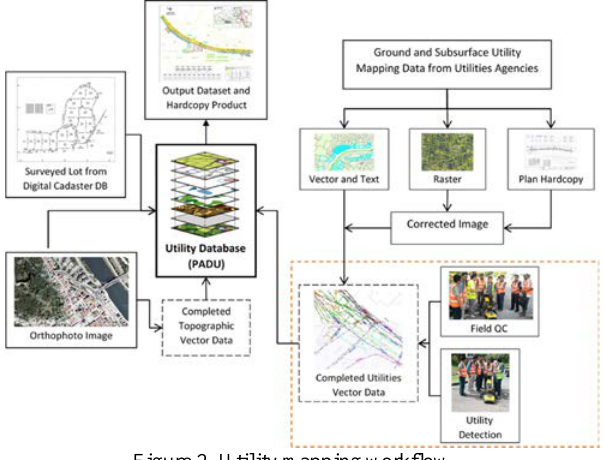
Figure 2. Utility mapping